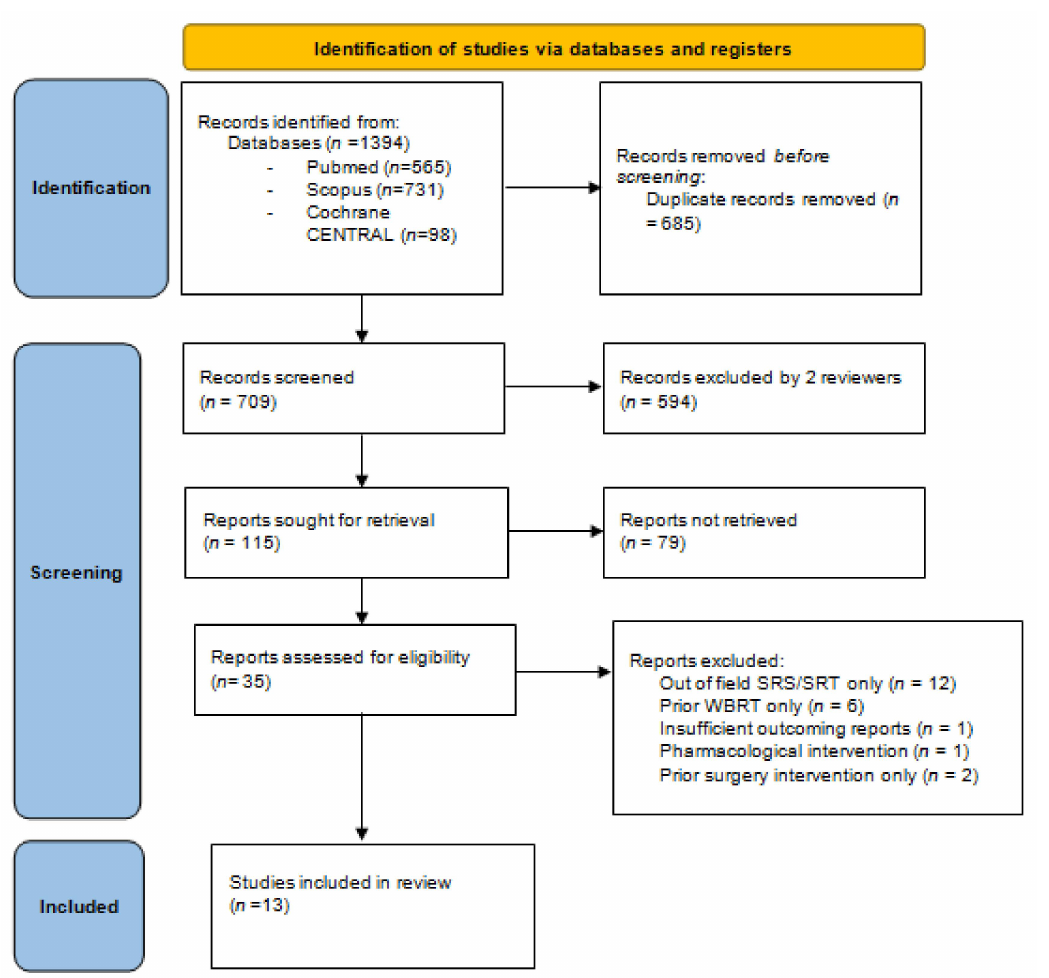
Figure 1. PRISMA 2020 flow diagram for our systematic review, which included searches of databases